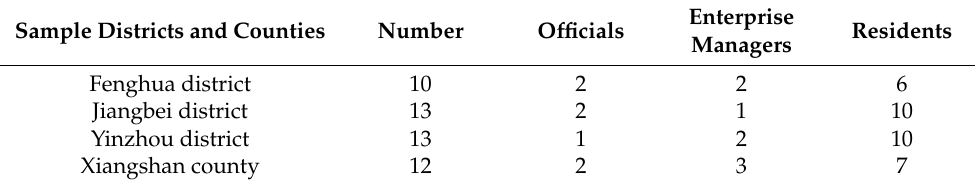
Table 1. The data of sample districts and counties. Sample Districts and Counties Number Officials